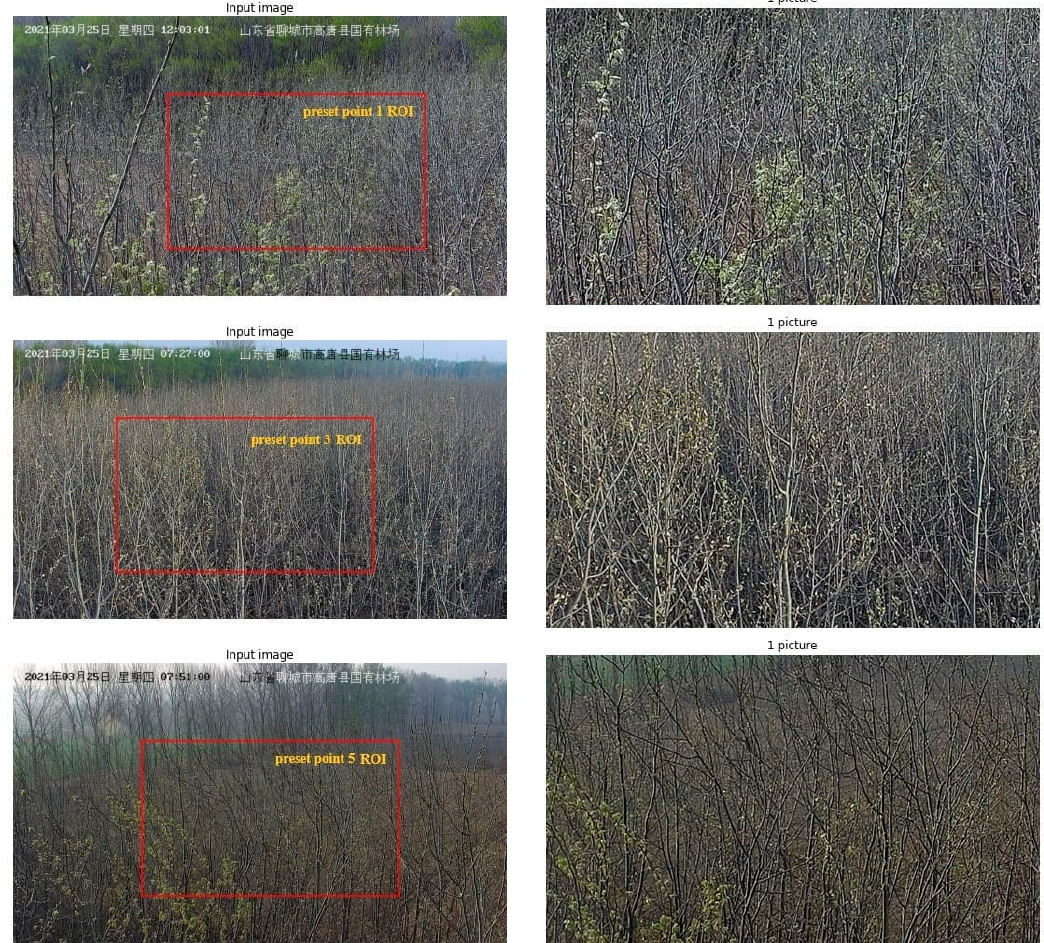
Figure 4. Preset point location and region of interest:(Image taken by state owned forest farm of Gaotang County, Liaocheng City, Shandong Province)